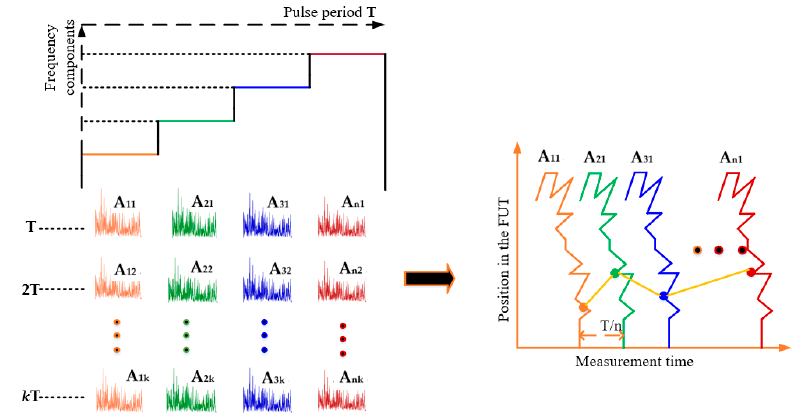
Figure 9. Signal processing for vibration measurement in FDM Φ‐ OTDR system.